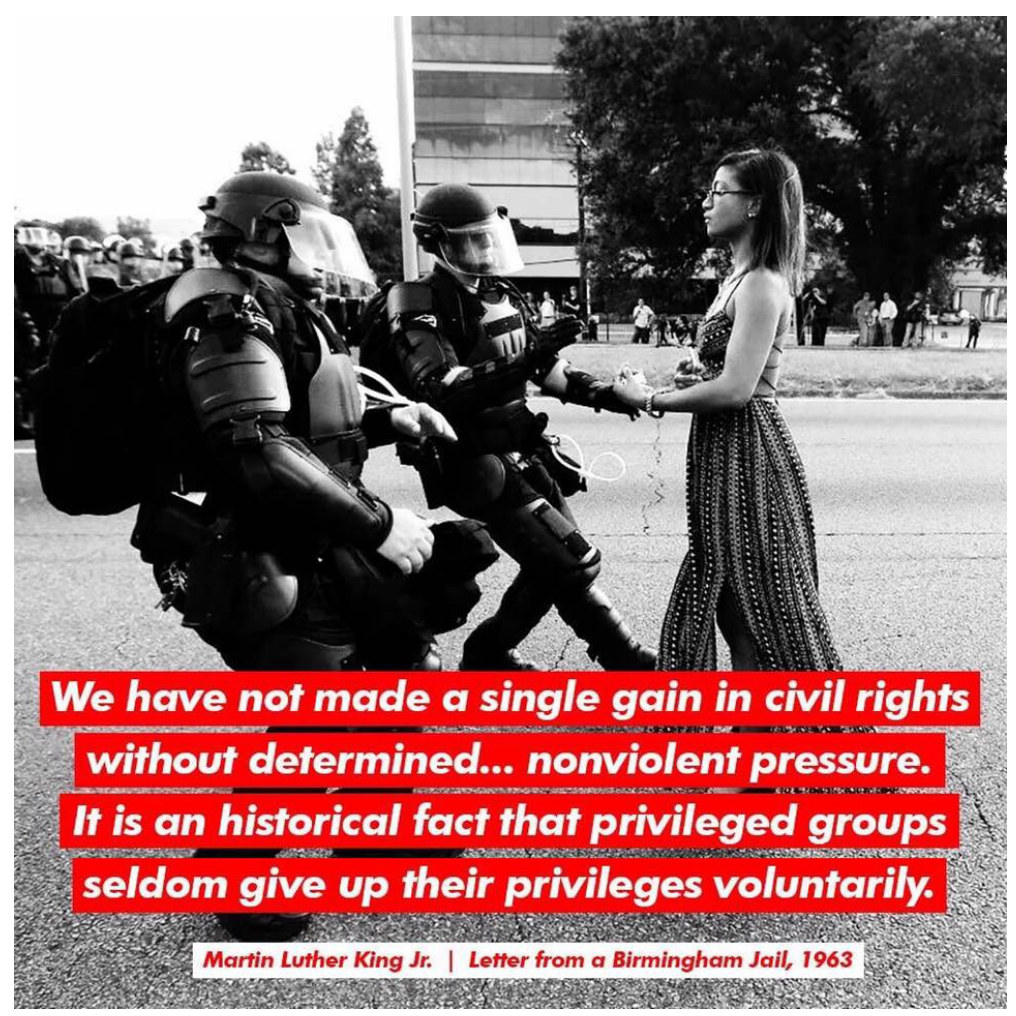
Figure 17. We have not made a single gain in civil rights without determined… nonviolent pressure. By Daniel Rarela (2017). Picture courtesy of the artist.